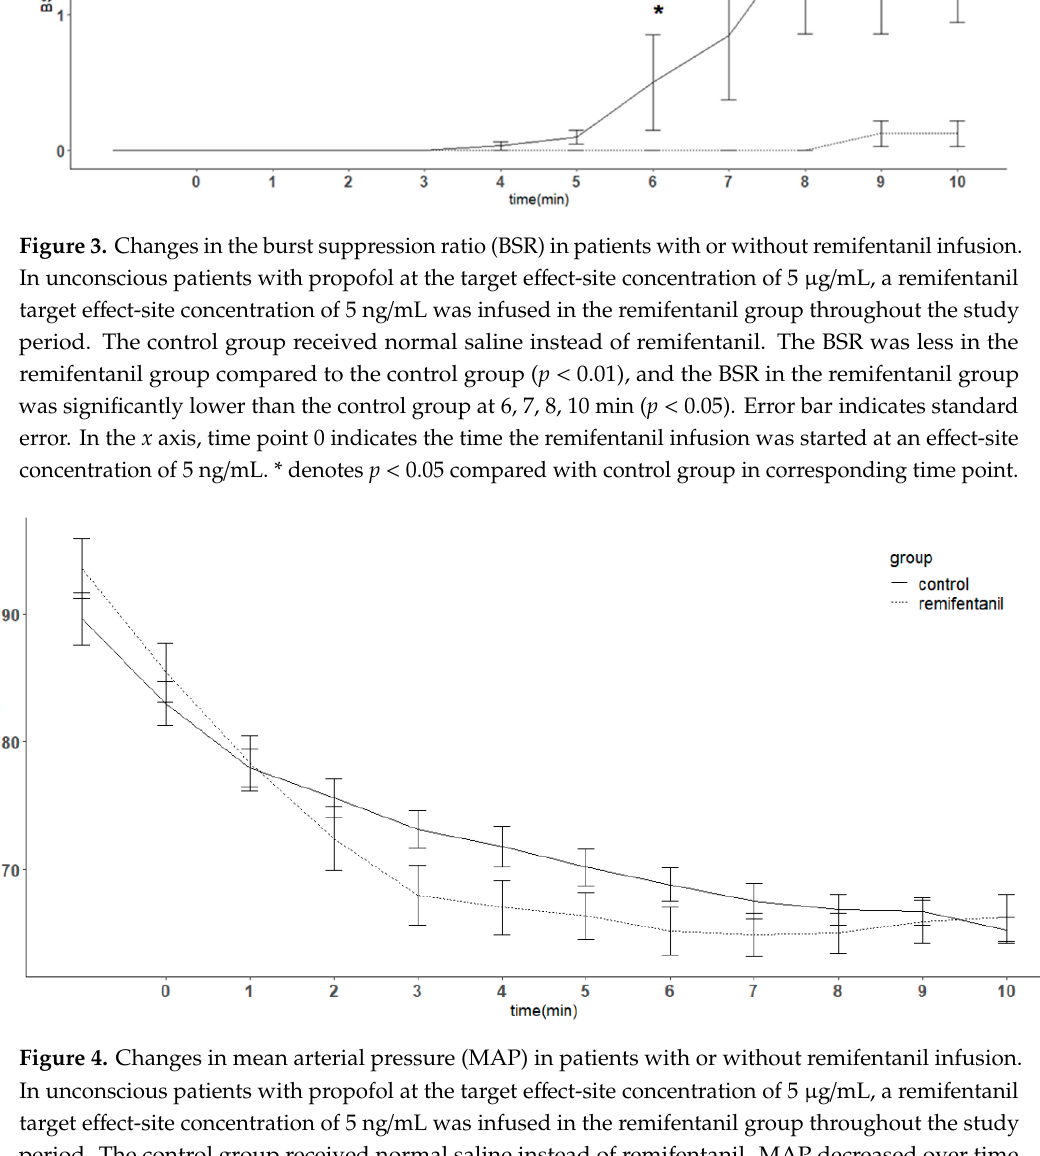
Table 2. Number of patients showing BSR ≥ 1% during 10 minutes of propofol-induced unconsciousness in the control and remifentanil groups.